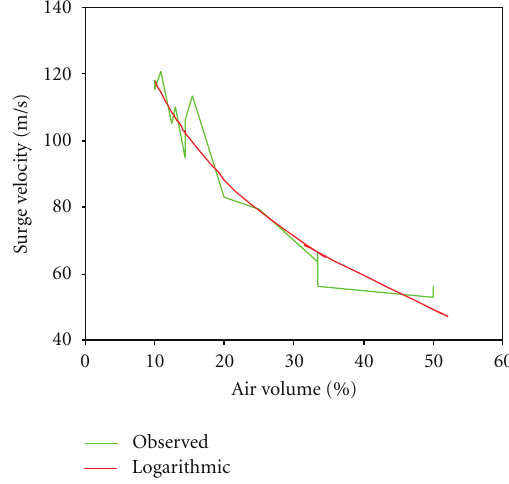
Figure 2: Logarithmic curve fit for surge wave speed of water pipeline with free water